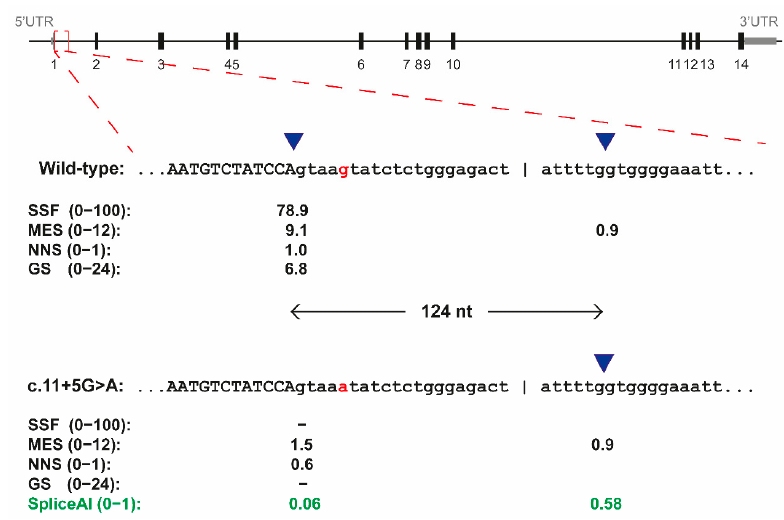
Figure 1. In silico splice-site predictions for the c.11+5G>A variant of RPE65 by Alamut 2.13. Schematic representation of the RPE65 gene and enlargement of the exon 1 and intron 1 for both the wild-type sequence and for the c.11+5G>A variant. Four in silico predictions of different algorithms are indicated below each sequence. The blue triangles indicated the position of splice donor sites, which are separate 124 nt. In red, the nucleotide on position c.11+5 is indicated. In green, the prediction by SpliceAI ( delta score ). SSFL, SpliceSiteFinder-like; MES, MaxEntScan; NNS, NNSPLICE and GS, GeneSplicer.